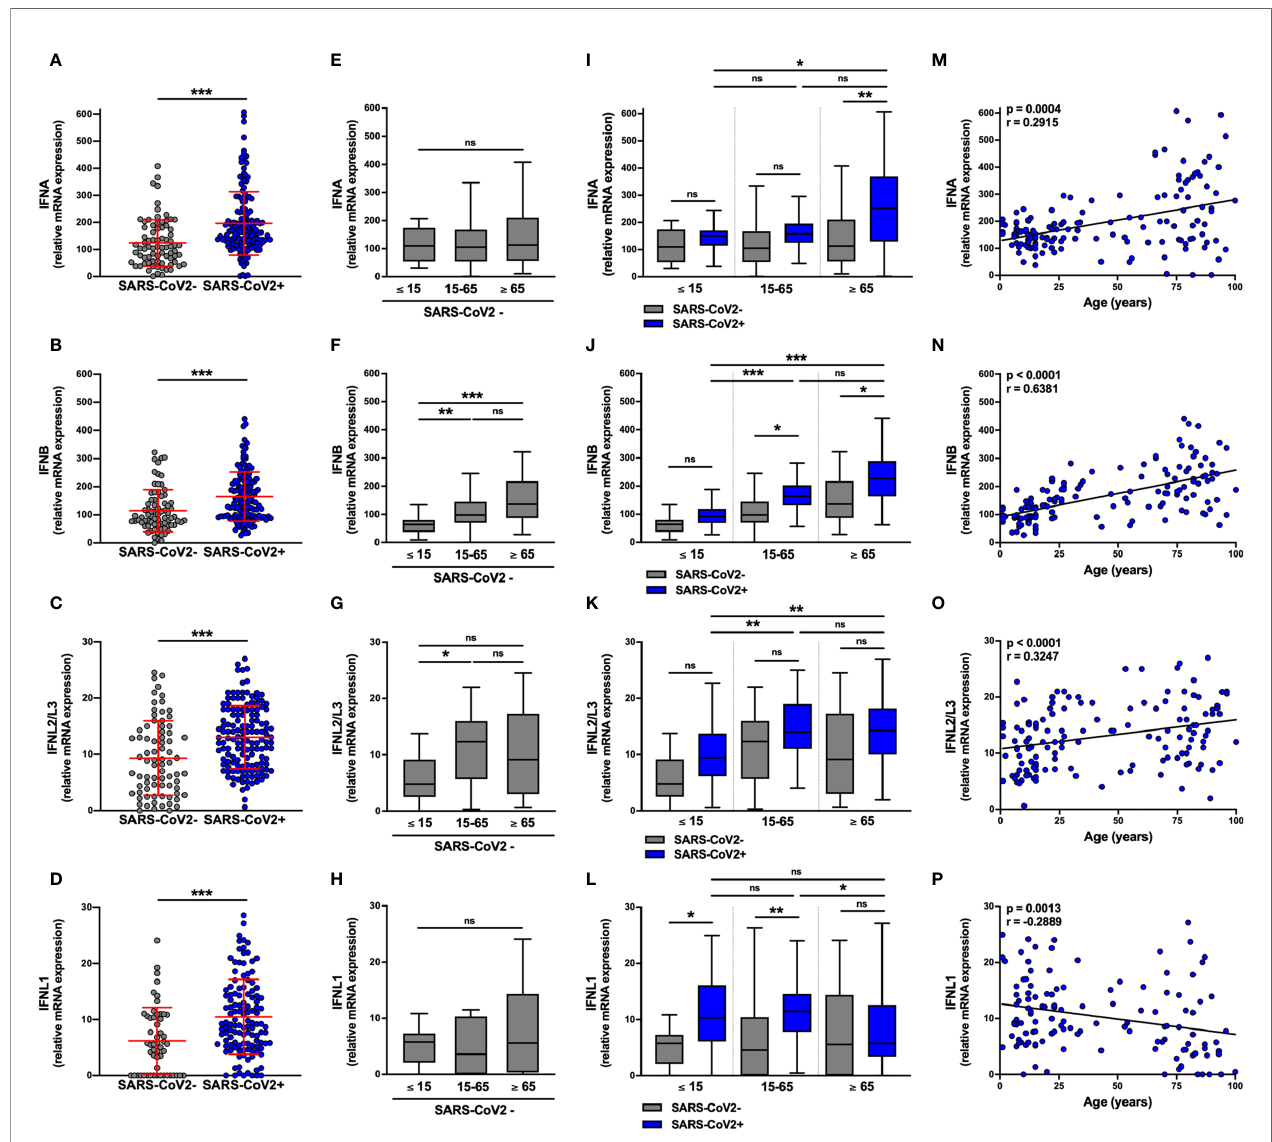
FIGURE 1 | IFN-I and IFN-III transcript levels are differentially increased in SARS-CoV-2-positive patients. The expression of IFNA , IFNB , IFNL2/L3 , and IFNL1 transcripts were determined by RT-qPCR in nasopharyngeal samples from SARS-CoV-2-infected (n=147, blue) or non-infected (n=79, grey) individuals. Data from the two groups are compared as a whole (A – D) , or according to the age of the individuals: ≤ 15 years old, 15-65 years old and ≥ 65 years old (E – L) . IFN transcript levels and age were correlated (M – P) . Each symbol represents a single individual. Boxplots represent the median and 25th to 75th percentiles and whiskers denote the maximum and minimum values. Data are compared using Mann-Whitney (A – D) , Kruskal-Wallis test followed by Dunn ’ s multiple comparison test (E – L) , or Spearman ’ s correlation (M – P) . *p < 0.05, **p < 0.005, ***p < 0.001. ns, not signi fi